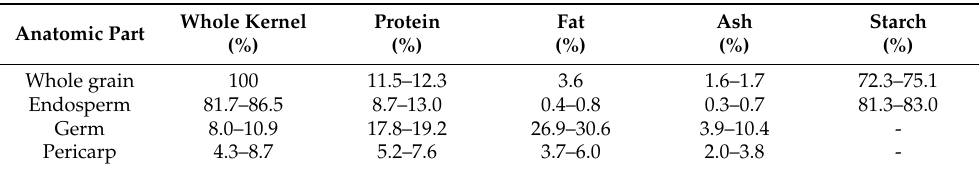
Figure 1. Kafirin structure. Image adapted from Zhu et al. [8] with permission from Elsevier. Sorghum grain chemical composition (Table 1) is influenced by genetic and environmental factors. A significant and inverse correlation has been observed for protein with grain weight and starch content, while the ash content was positively correlated with protein content [9]. The main carbohydrates found in sorghum grains are starch, soluble sugar, and fiber. Sorghum is a rich source of slowly digestible starch (SDS), which is beneficial for the digestion and intestinal absorption of carbohydrates in intestine, while the raised amount of dietary fiber (9.7–14.3 g) contributes to digestion enhancement and carbohydrate and cholesterol metabolization [9,10]. Sorghum grain contains low amounts of fat, which is mainly found in the scutellar zone of the germ [9]. Kim et al. [10] reported that sorghum grain contains compounds that could be introduced in foods or dietary supplements to regulate cholesterol levels. Sorghum is rich in minerals and vitamins, which are mainly found in the aleurone coating and germ, being an important fount of B vitamins, except for vitamin B 12 [11]. Table 1. Sorghum grain fraction chemical composition, adapted from Taylor and Duodu [12] with permission from Elsevier.